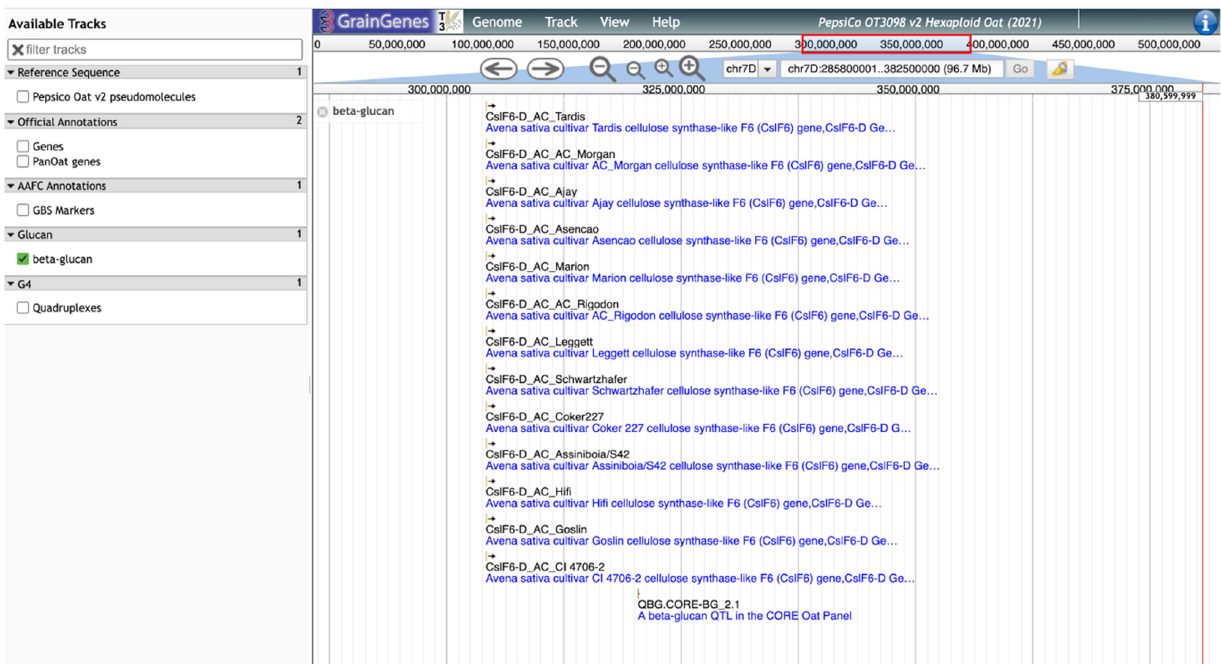
Figure 5. JBrowse view of the manually curated track for β -glucan QTL and cloned alleles for cellu- lose synthase-like (Csl) aligned on the 7D chromosome of the PepsiCo OT3098 v2 browser.